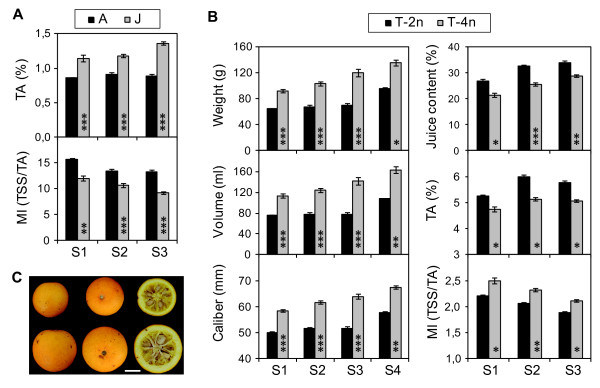
Graphic representation of the significant and consistent effects detected in the analysis of fruit quality in the sweet orange and citrange lines. A) ‘ontogeny’ effect detected in sweet orange lines. B) ‘Ploidy’ effect detected in citrange lines. C) Images showing the representative appearance of mature diploid (2n) and tetraploid (4n) fruit from Carrizo citrange trees. The scale bar represents 2 cm. Level of significance achieved in the planned contrasts: *p < 0.01; **p < 0.001; ***p < 0.0001. Seasons analyzed: S1, season 2004; S2, season 2005; S3, season 2006; S4, season 2007. Average ± SE from contrasts showing significant differences (p < 0.01) in at least two seasons are represented.